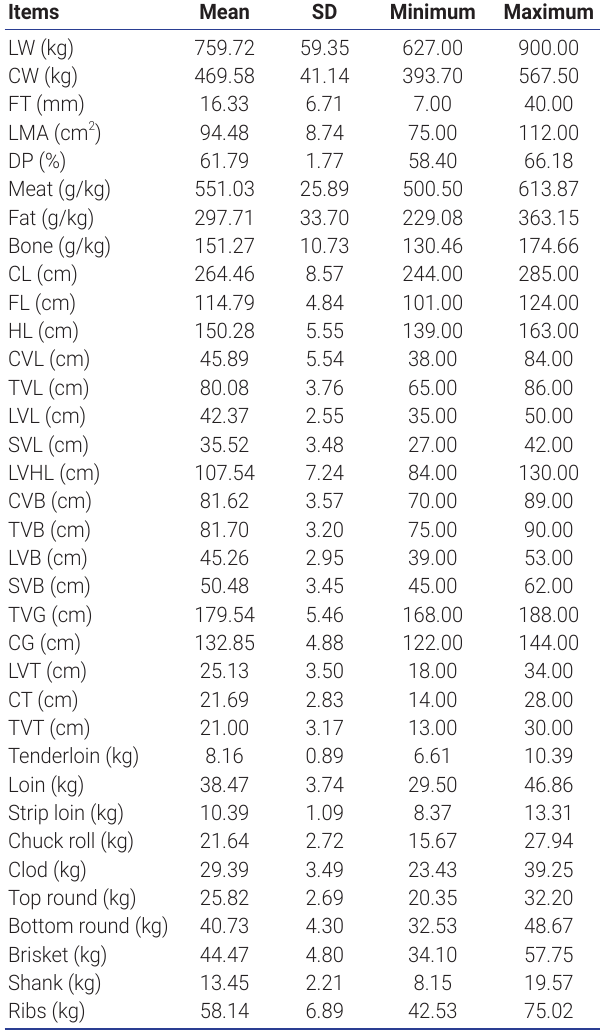
Table 2. Mean, standard deviation (SD), minimum and maximum values of carcass traits and primal cuts yields